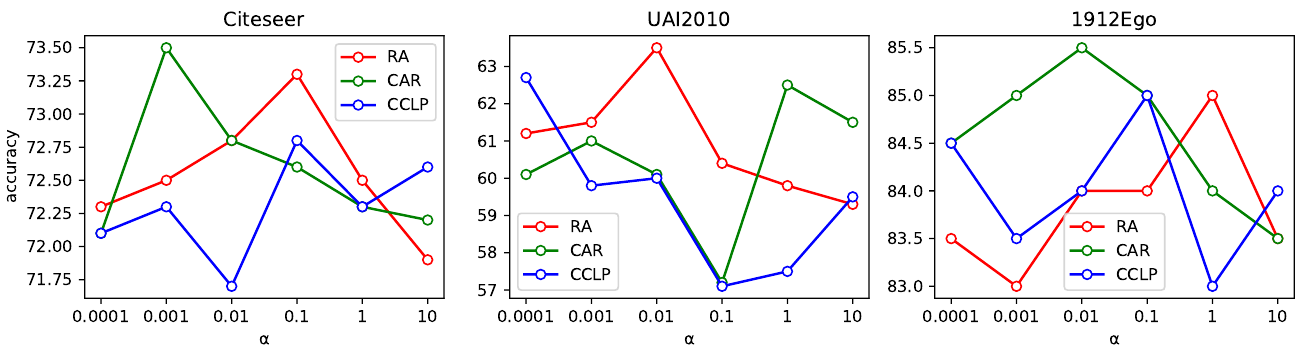
Figure 3. Parameter sensitivity analysis on Citeseer, UAI2010 and 1912Ego. The x-axis is the values of α , and the y-axis represents the accuracy